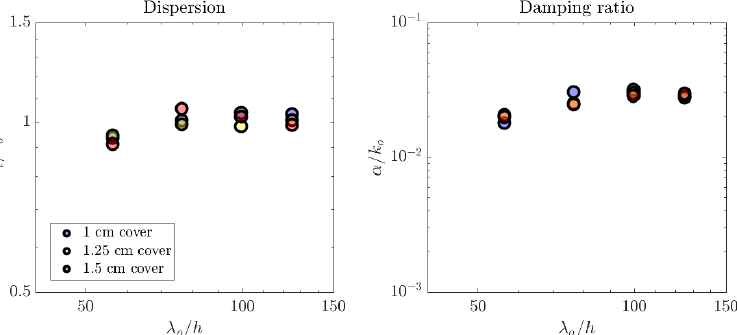
Figure 11. Results of different scales found by using the present computational model. Left and right panels respectively show the dispersion and attenuation rates at different incoming wavelengths.